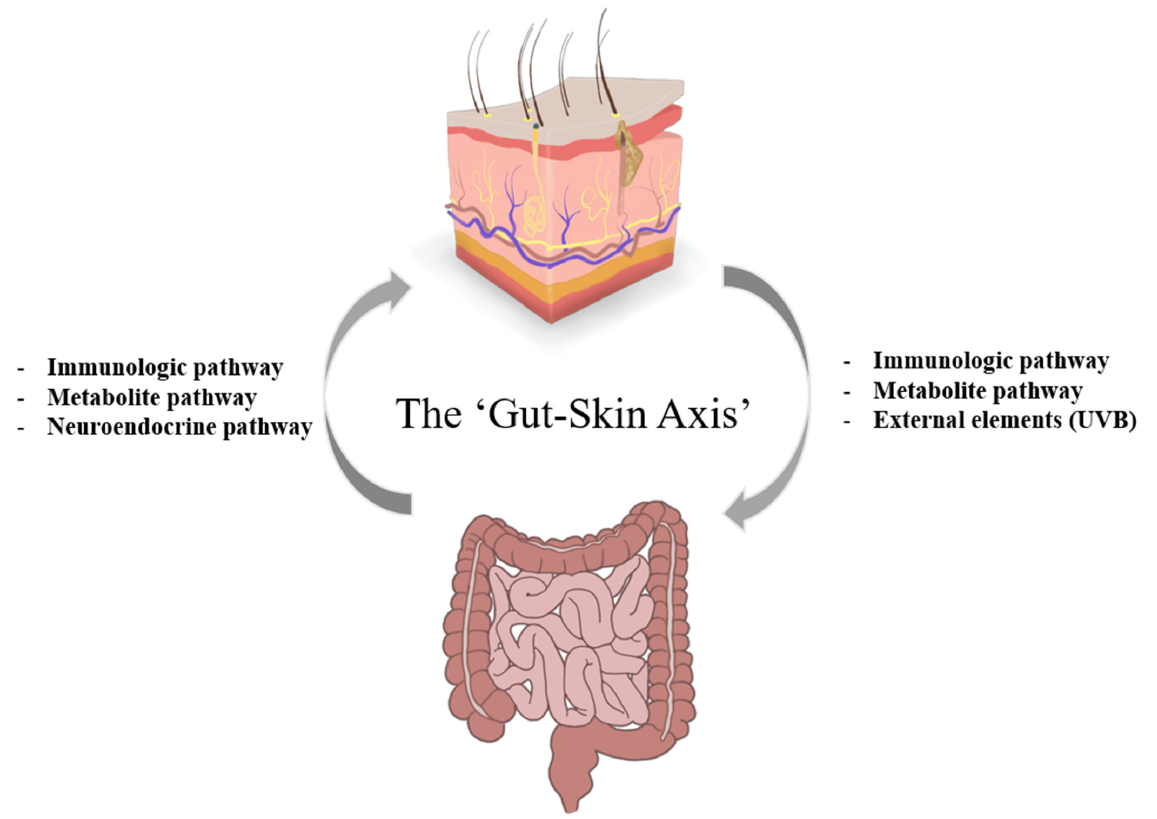
Figure 1. Several potential pathways of the gut–skin axis in atopic dermatitis (AD). In particular, numerous studies have shown that toxins in the gut microbiome are a potential problem for AD patients. Intestinal microbes are known to influence the skin through immunological, metabolic, and neuroendocrine pathways. The effect of the skin microbiome on the intestinal immune system has been mainly investigated in the field of food allergies, which shows how skin microorganisms affect the gut of AD patients. Recently, skin exposure to ultraviolet B (UVB) was shown to change the gut microbiome.